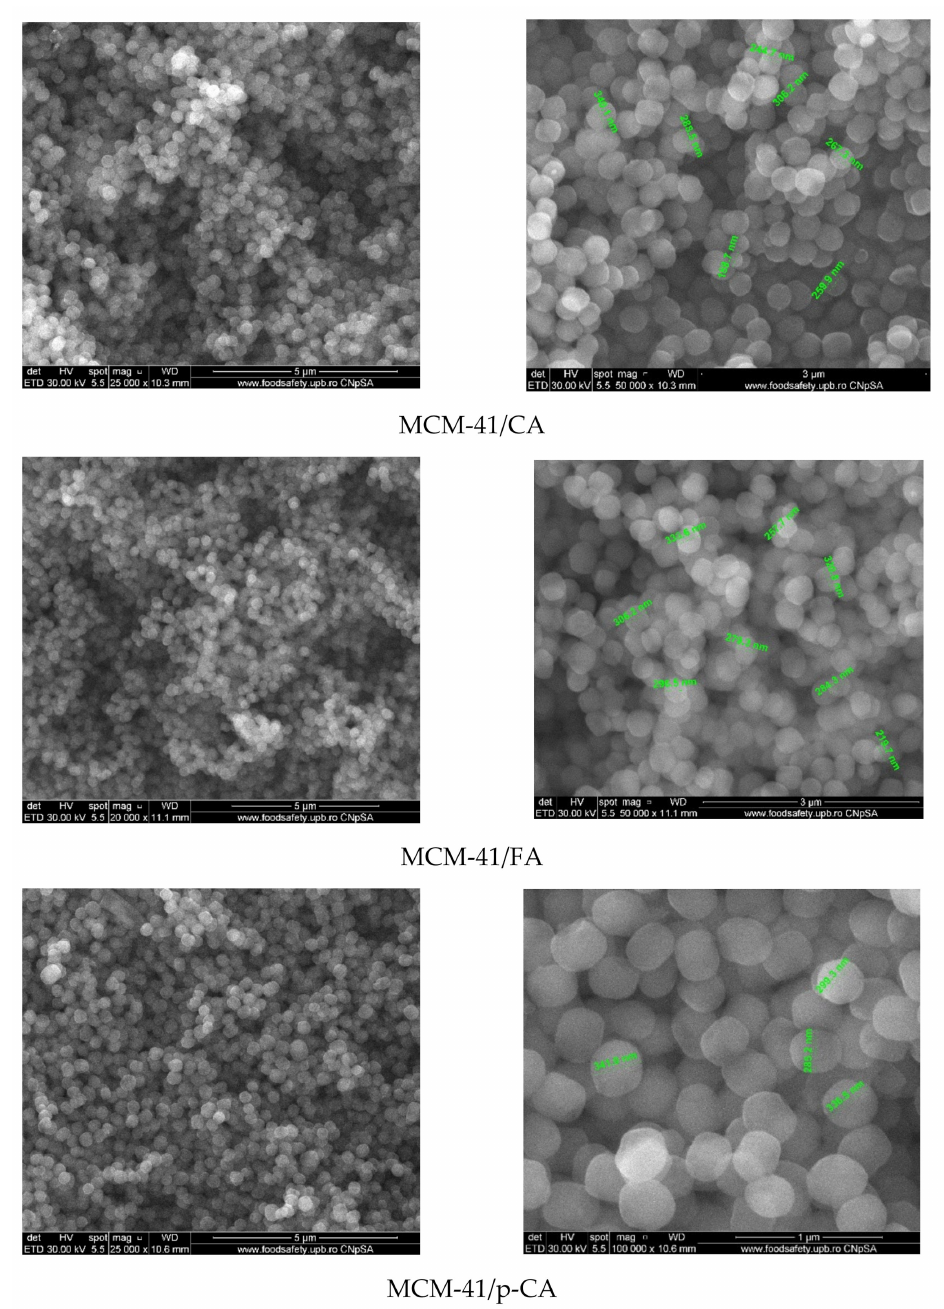
Figure 10. SEM images of MCM-41 mesoporous materials loaded with polyphenols. Scanning electron microscopy images recorded on MCM-48 mesoporous material (Figure 11) show the quasi-spherical morphology of silica particles with varying sizes in the range of 150–400 nm. Compared to MCM-48, the SEM images of MCM-48/polyphenols) show some heterogeneous areas in the form of agglomerates, which can be attributed to the presence of polyphenols but there were no significant changes such as strong agglomer- ations or entrapment of the mesoporous materials within the polyphenolic